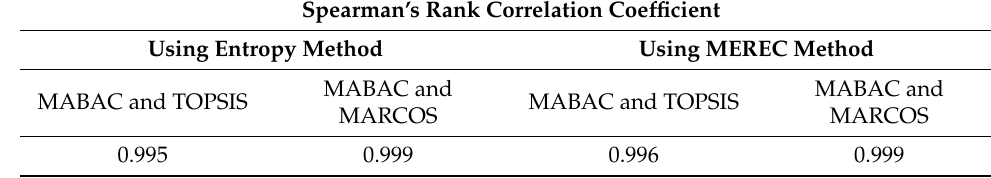
Table 8. Spearman’s rank correlation